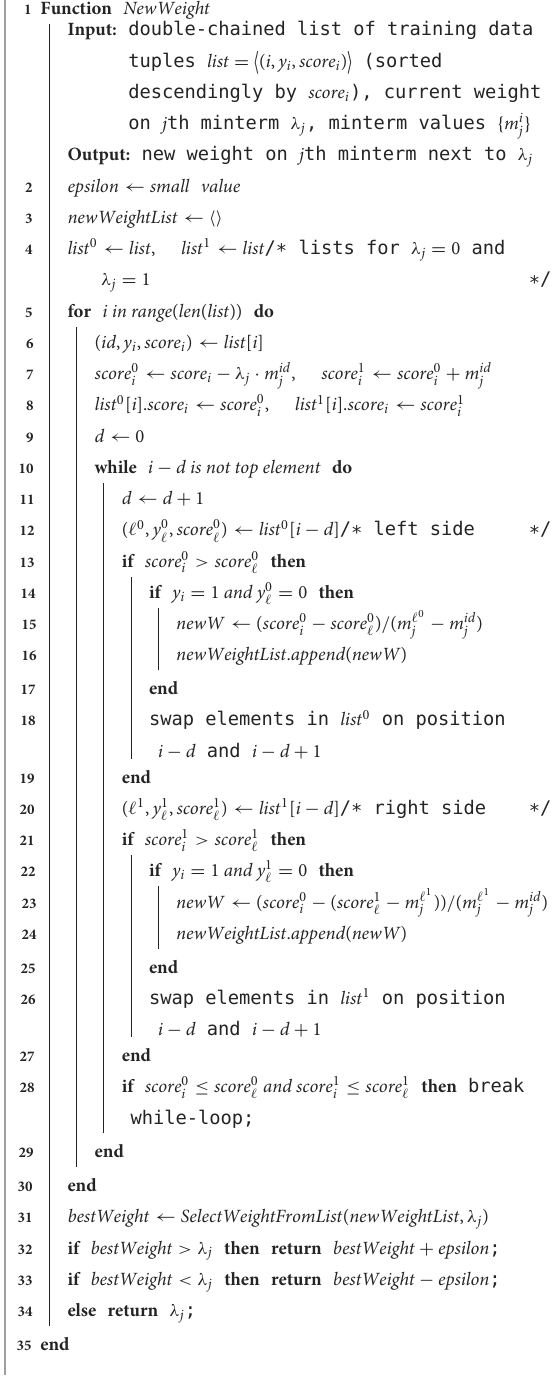
1 Function NewWeight Input: double-chained list of training data